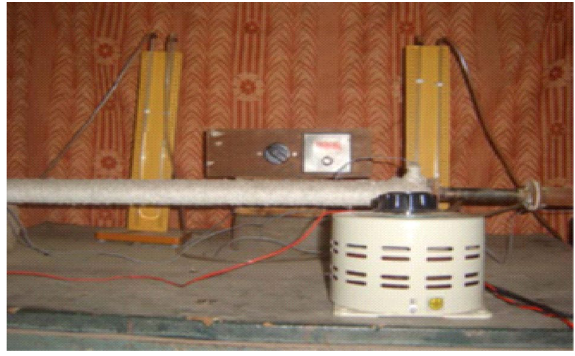
Fig. 2 Photograph of the experimental setup